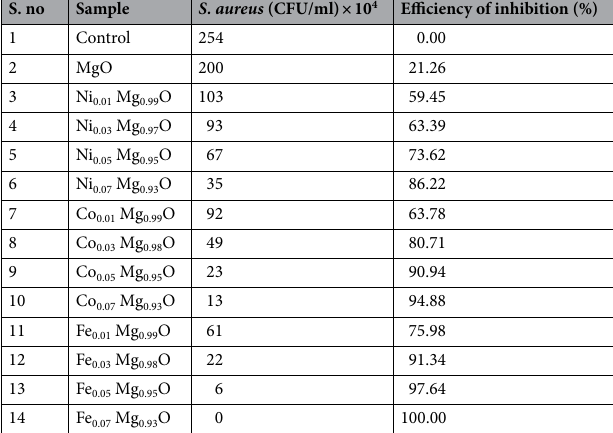
Table 9. The efficiency of inhibition of Ni, Co, and Fe-doped MgO nanoparticles at 80 μg/ml against S.